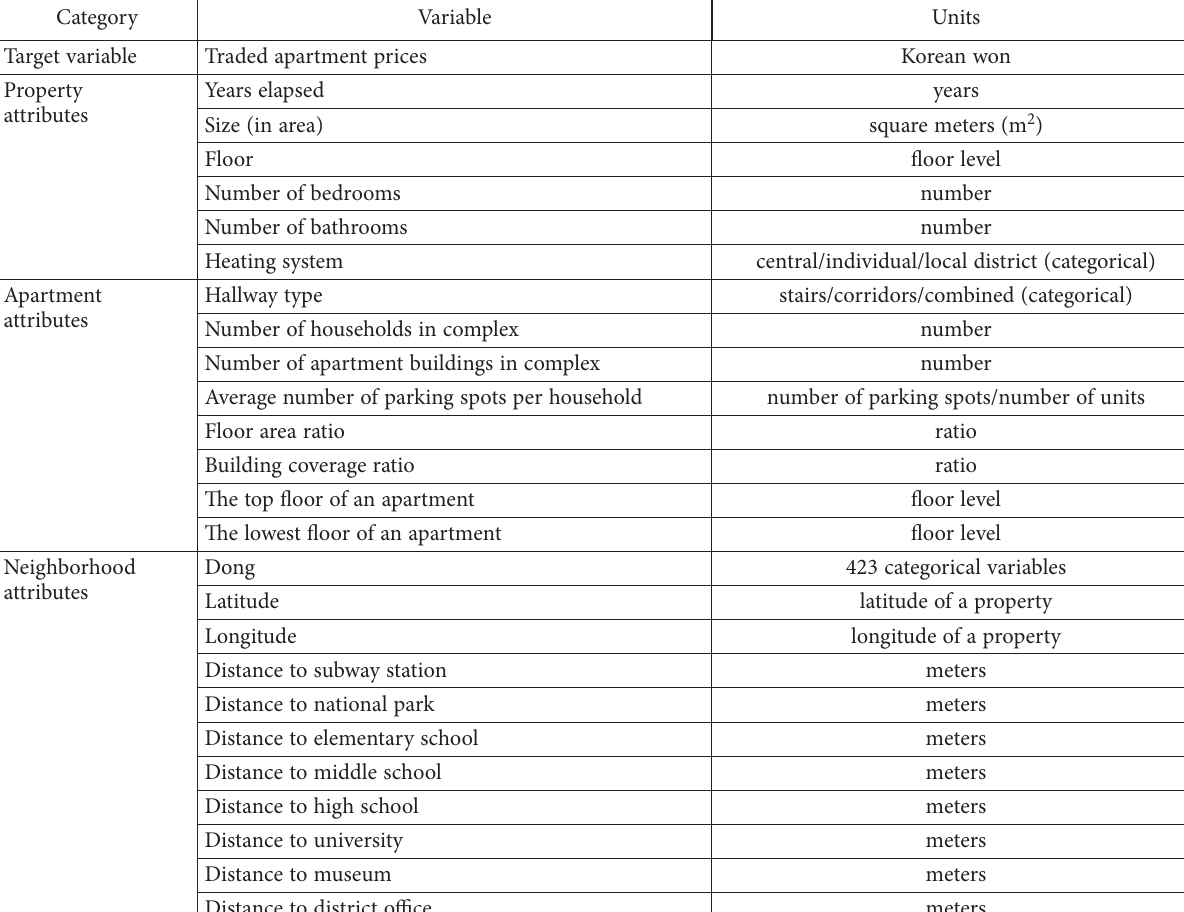
Table 1. The variables used in our